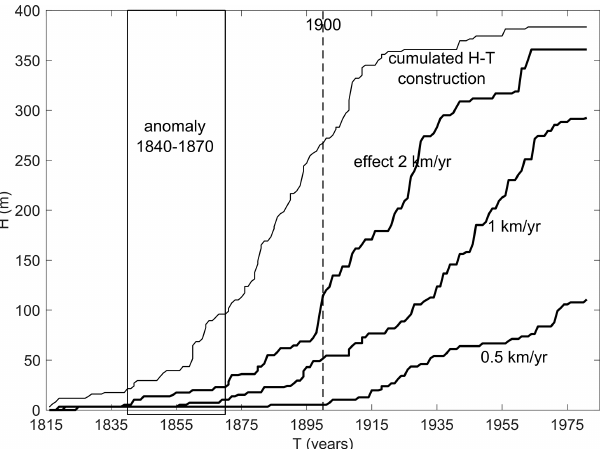
Figure 9. Cumulative height H (m) versus calendar date for the installation of factories in the middle reaches of the river (data in Alayo, 2017) and its effects at the upper border of the lower Llobre- gat, under three assumptions of disturbance